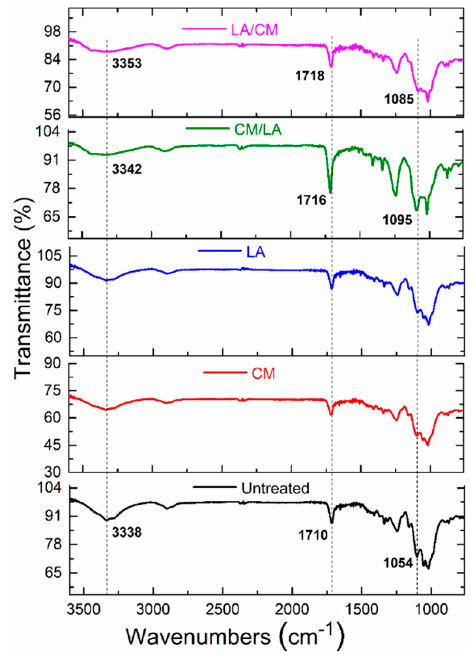
Figure 4. FTIR spectra of untreated and treated samples.